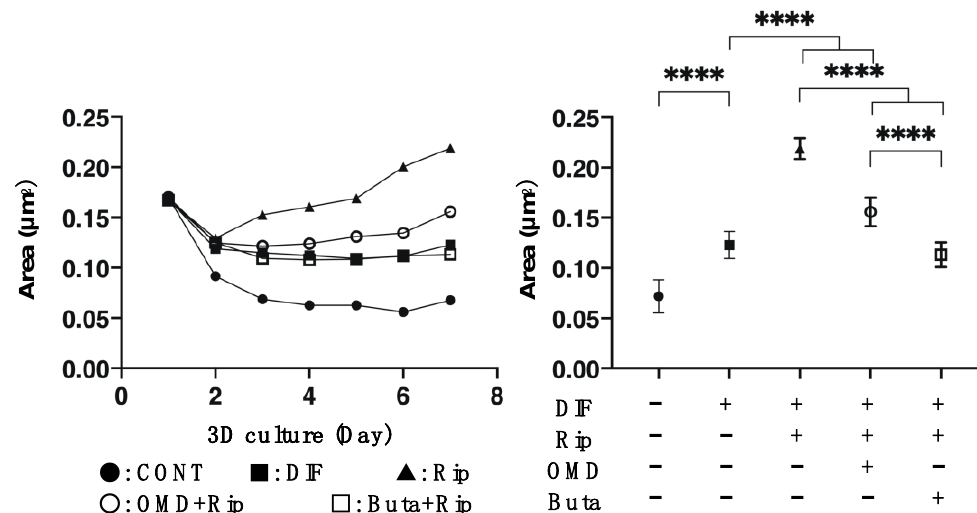
Figure 3. Additive effects of EP2 agonists to ripasudil (Rip) on the mean sizes of the 3T3-L1 3D organoids during adipogenesis. The 3D organoids of 3T3-L1 cells were prepared under several sets of conditions: preadipocytes of 3T3-L1 cells (DIF-) or adipogenic differentiation (DIF+) with or without a combination of 10 µ M ripasudil (Rip) and the EP2 agonist, 100 nM omidenepag (OMD) or 100 nM butaprost (Buta). Their mean area sizes ( μ m 2 ) were measured and plotted during a 7-day culture period (left panel) and those at Day 7 were compared among the experimental groups (right panel). All experiments were performed in triplicate using fresh preparations, each consisting of 16 organoids. Data are presented as the arithmetic mean ± the standard error of the mean (SEM). **** p < 0.001 (ANOVA followed by a Tukey’s multiple comparison test).